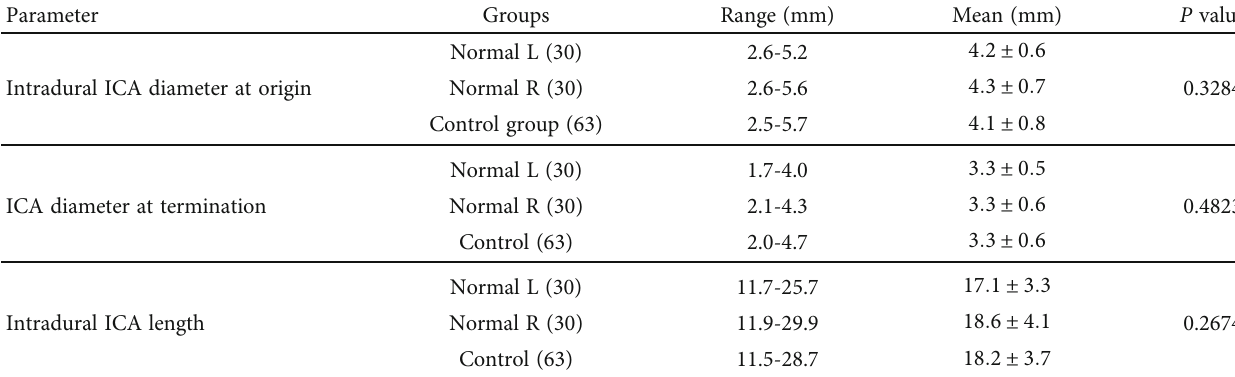
Table 4: Statistical analysis among the left and right normal ICAs and the control